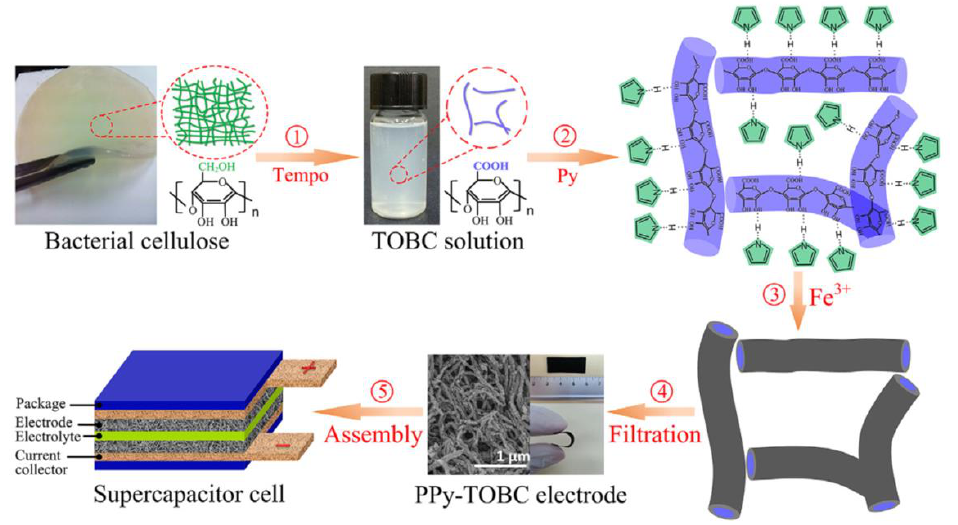
Figure 8. Schematic process of the fabrication and layered structure of supercapacitor cell. Reprinted with permission from ref. [124]. 2016 Elsevier.